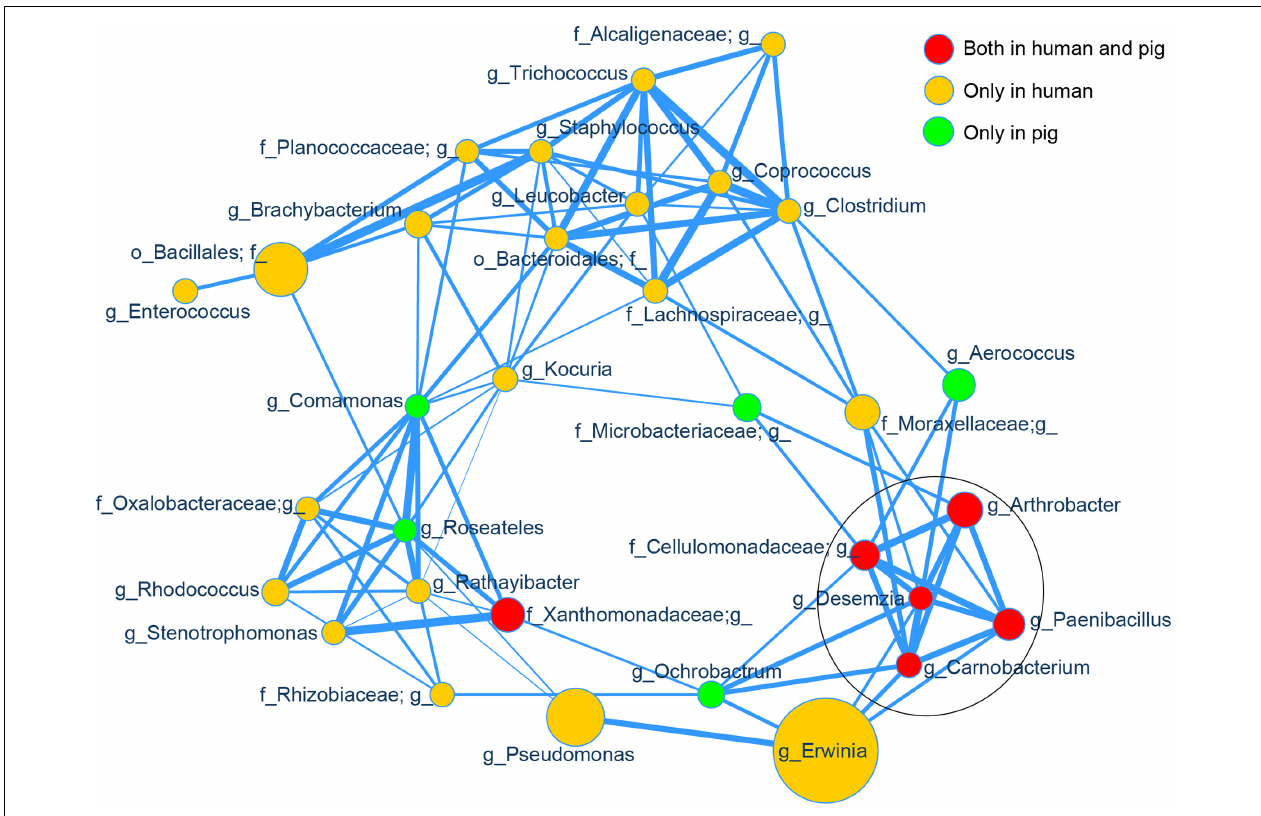
FIGURE 5 | Correlation network of the high altitude specific skin taxa. The relative abundances of the top 32 high altitude specific skin bacterial genera identified by LEfSe were used as input for SparCC correlation analysis and visualized via a customized Cytoscape network. Data for all samples (both human and pig) were included. The node size represents the scale of taxon abundance while edges represent the significant positive correlations between two linked nodes ( p < 0.01). Edge width represents the size of SparCC correlation coefficient. All relative abundances and SparCC coefficient values used for network plotting were normalized via the continuous-mapping method in Cytoscape. The encircled nodes are part of the most densely connected region identified by MCODE